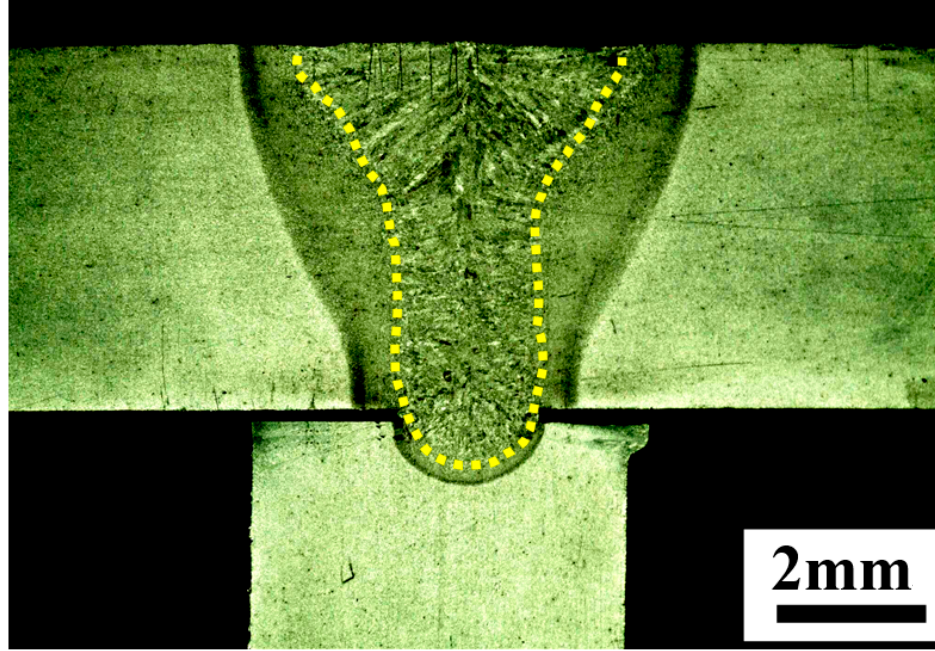
Figure 7. Cross sectional profile of welding bead without pores.